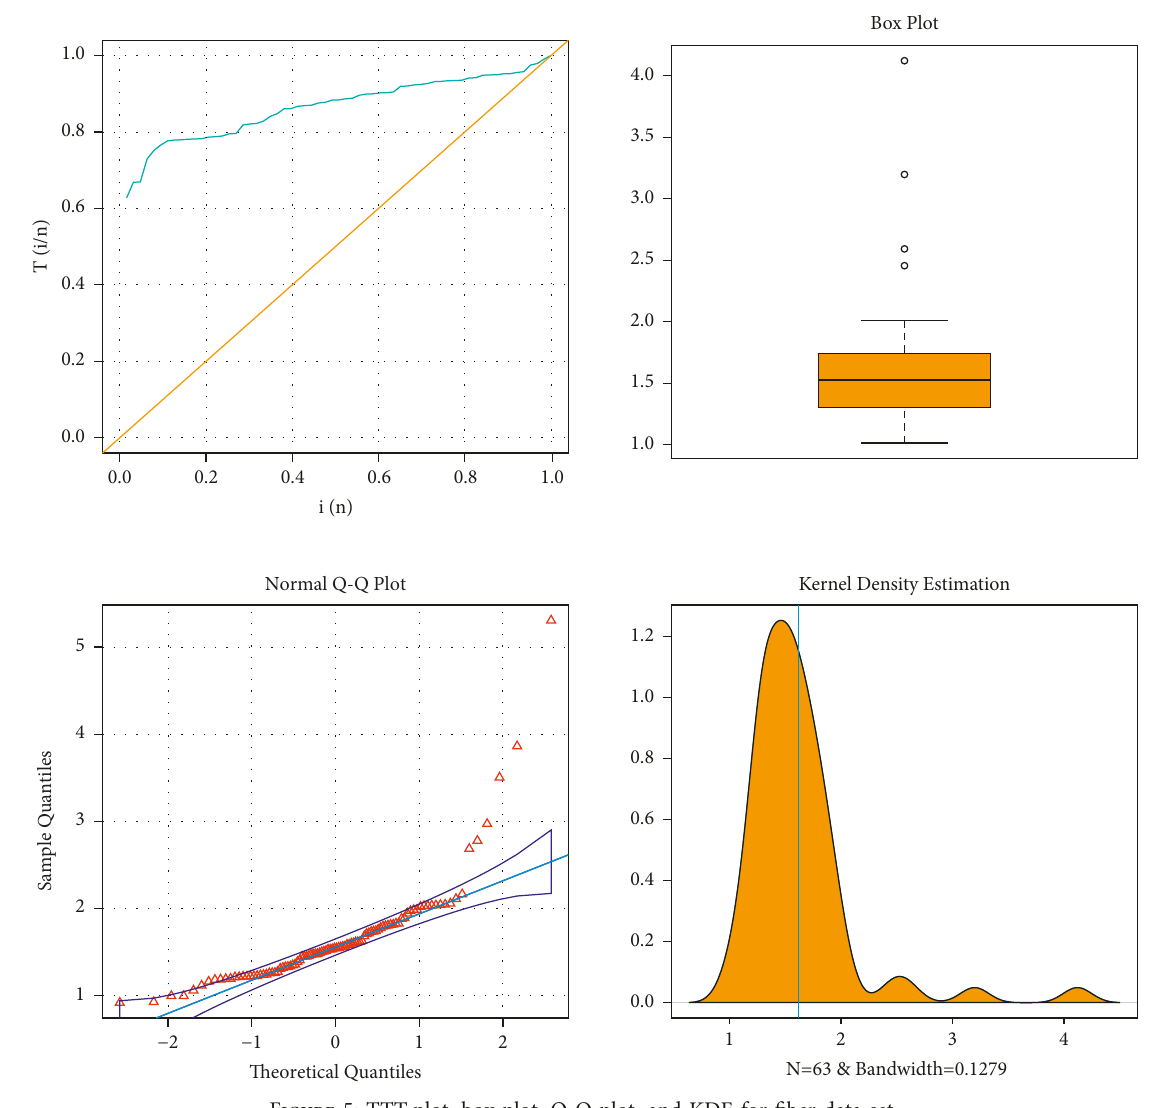
Figure 5: TTT plot, box plot, Q-Q plot, and KDE for fiber data